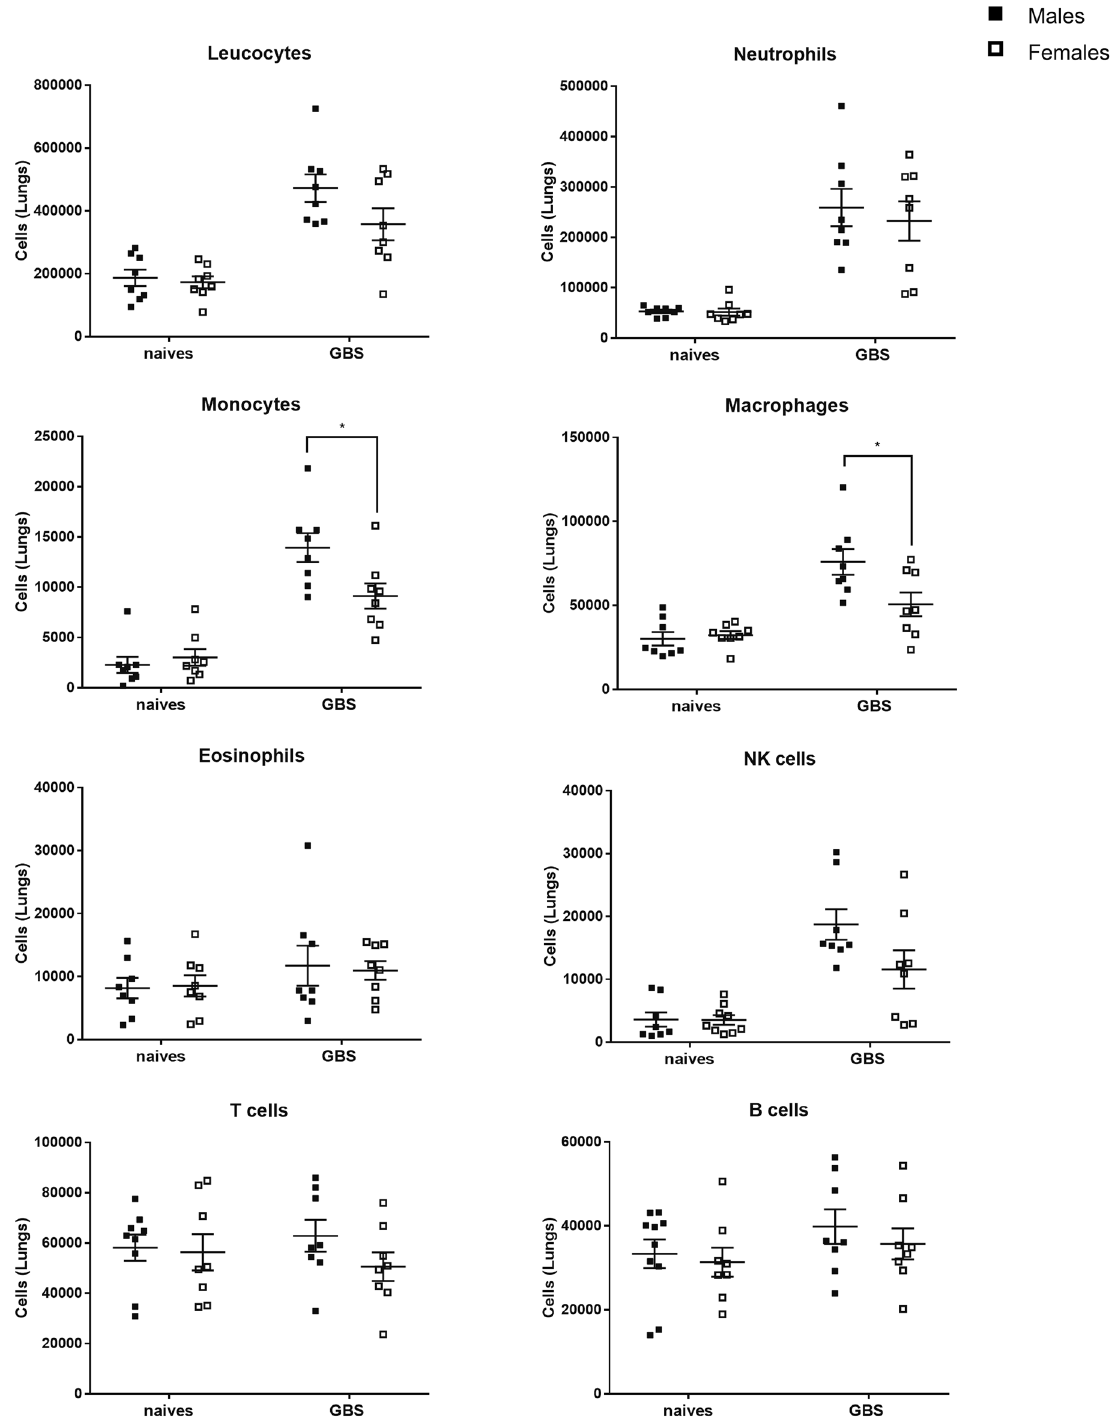
Figure 2. Sex-difference of immune cells in the lungs of naive and GBS-infected mice. Flow cytometry was performed before or after 24 h of GBS infection in male (black) and female (white) mice (n = 8 for each group) using specific antibodies. Levels of leucocytes (CD45 +), neutrophils (CD45+, CD11b+, MHCII−, CD24+, Ly6G+, Siglec F−), eosinophils (CD45+, CD11b+, MHCII−, CD24+, Ly6G−, Siglec F+), monocytes (CD45+, MHCII−, CD11b+, CD64+), macrophages (CD45+, MHCII+, CD64+, CD24−), T cells (CD45+, CD11c−, CD11b−, MHCII−, CD24−), B cells (CD45+, CD11c−, CD11b−, MHCII+, CD24+) and NK cells (CD45+, MHCII−, CD64−, CD11b±) are shown. *p < 0.05 (Mann–Whitney U test). Data are representative of two independent